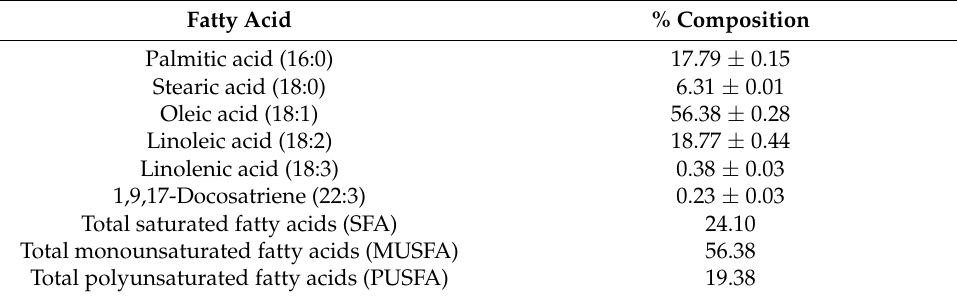
Table 4. Fatty acid composition of Balanites roxburghii seed oil. Fatty Acid % Composition Palmitic acid (16:0)